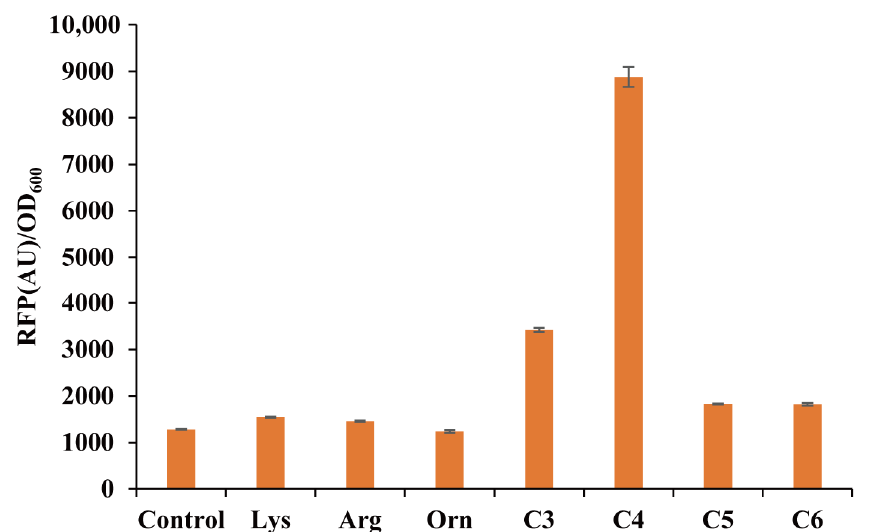
Figure 3. Ligand-specificity testing of pSenPuuR. Amino acids and diamine compounds were detected at a concentration of 20 mM by pSenPuuR. L-lysine (Lys), L-arginine (Arg), L-ornithine (Orn), 1,3-propylenediamine (C3), 1,4-butanediamine (C4), 1,5-pentanediamine (C5), and 1,6-hexanediamine (C6). Values are presented as the mean ± standard deviation of three independent experiments.